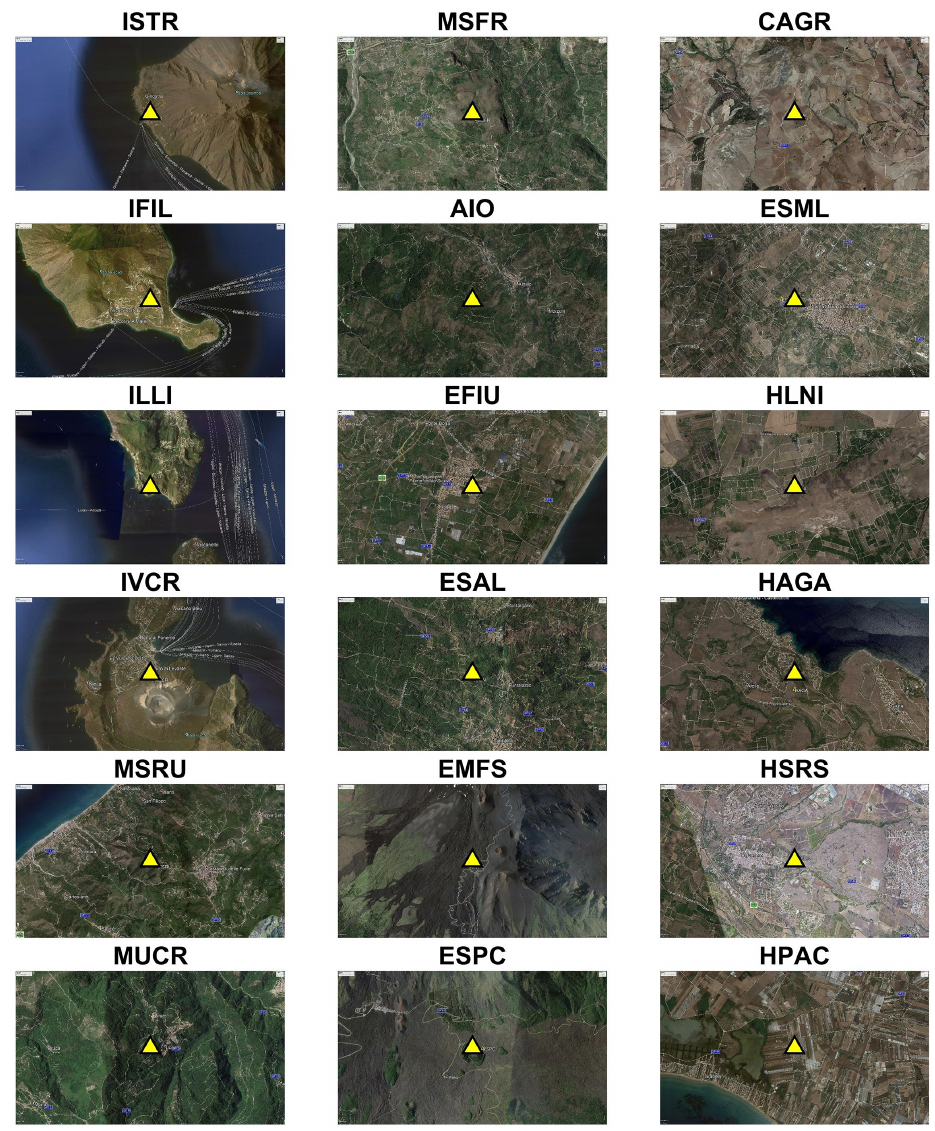
Figure A1. Photos from © Google Earth of the installation site areas of the seismic stations (yellow triangles) used in this work. The width of the area shown in each picture is ∼ 5km. The stations are sorted by decreasing latitude from upper left to bottom right.